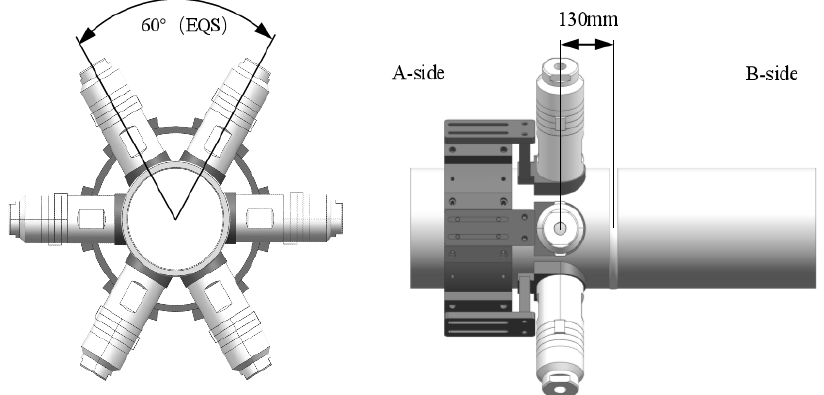
Figure 2. Schematic diagram of ultrasonic stress regulation scheme layout.